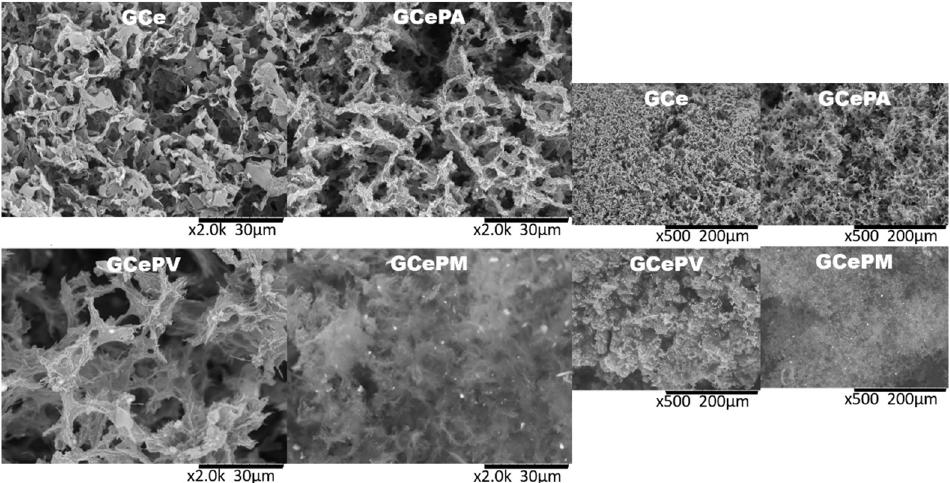
Figure 7. SEM images of monolithic samples at 2000× magnification ( left images ) and 500× magnification ( right images ).